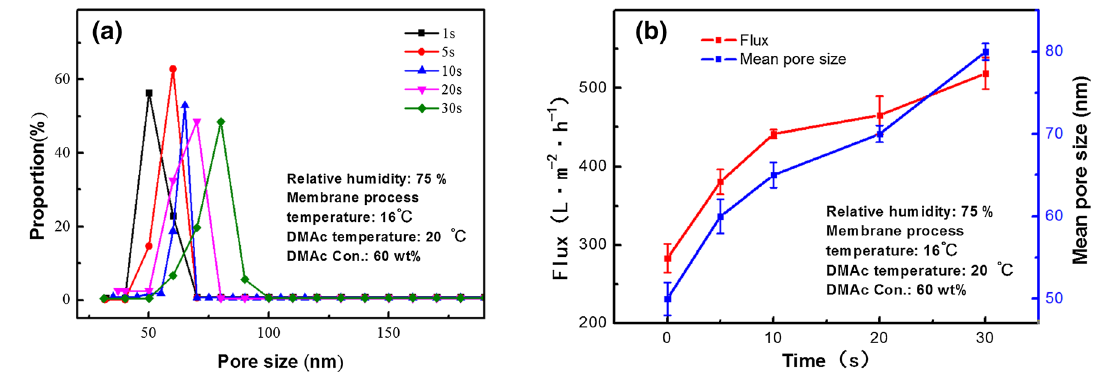
Fig. 7 a The pore size distributions and b the PWF distributions of membranes prepared in different exposure times of air